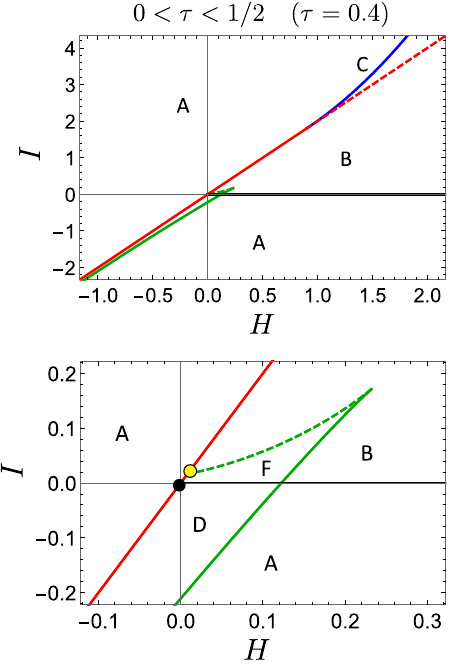
FIG. 16. Bifurcation diagram Σ for the insert strength value τ ¼ 0 . 4 , dividing the ð H; I Þ plane into six distinct regions. (Upper) Default view. (Lower) Scaled-up view near ð H; I Þ ¼ ð 0 ; 0 Þ , in which the region of type F is visible.